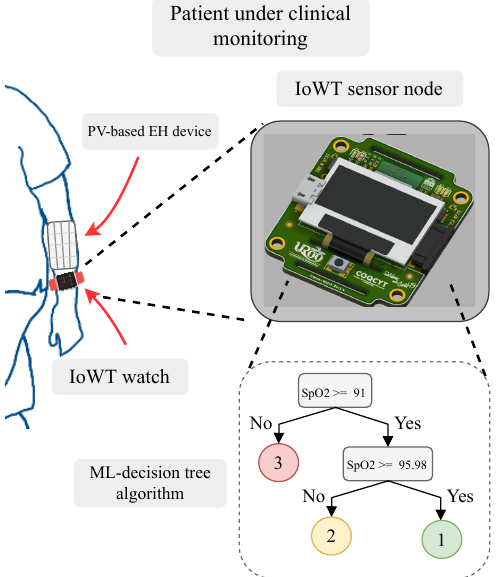
Figure 1. Conceptual idea of the proposed wearable IoT sensor node, which implements ML-based dynamic power management strategies.